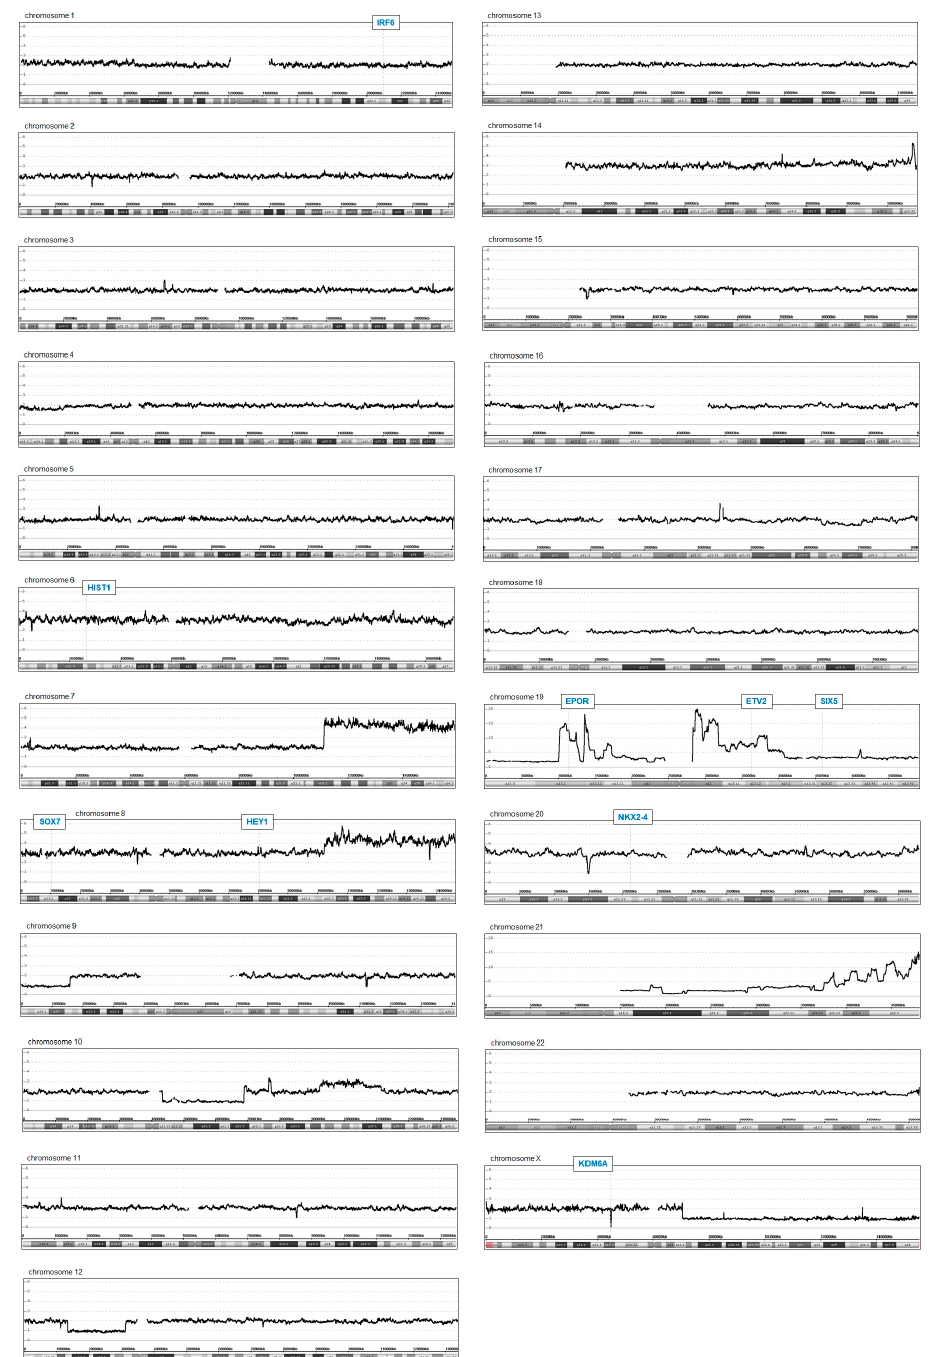
Figure 2. Genomic profiling data of OCI-M2. The data show copy number states for all chromosomes. The y-axis indicates the copy number state, the x-axis the chromosomal position. Selected gene loci are indicated, including IRF6 , HIST1 , SOX7 , HEY1 , EPOR , ETV2 , SIX5 , NKX2-4 , and KDM6A .